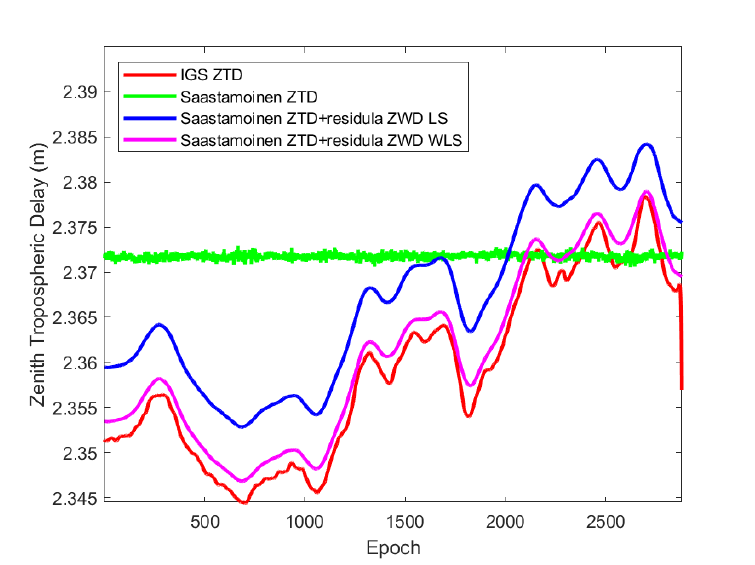
Figure 7. Zenith Tropospheric Delay from IGS and computed with LS and